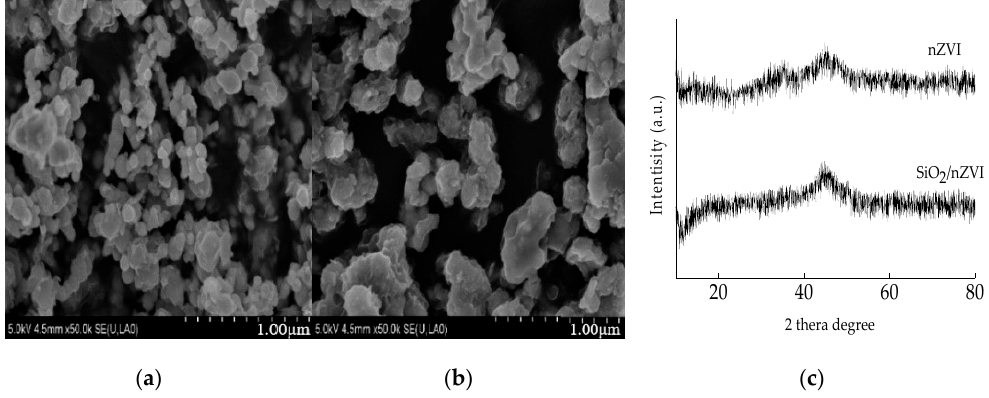
Figure 1. Scanning electron microscope (SEM) images of ( a ) nanoscale zero-valent iron (nZVI), ( b ) SiO 2 -coated nZVI (SiO 2 /nZVI), and ( c ) X-ray diffraction (XRD) patterns of nZVI and SiO 2 /nZVI.